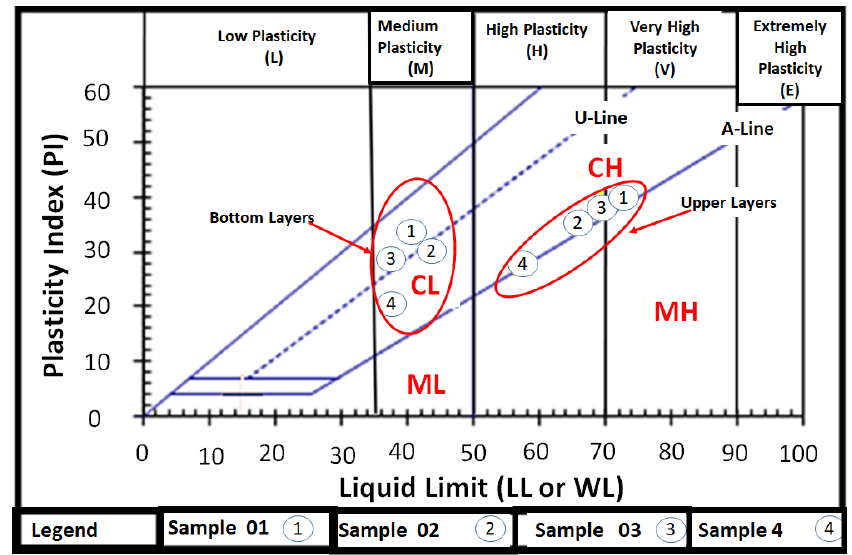
Figure 7. Plasticity index charts of collected soil samples. The focus is on the upper layer zone of the soil mass.